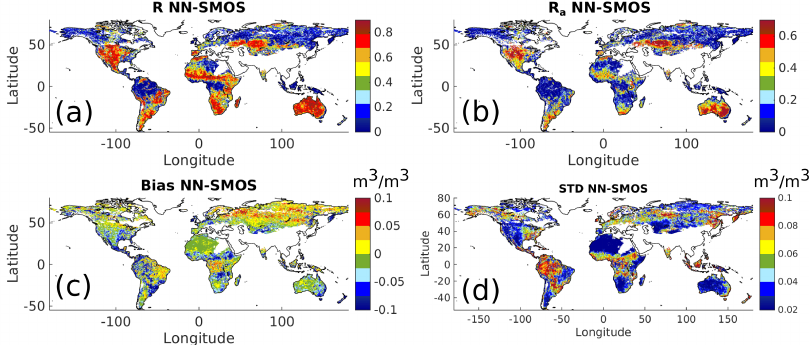
Figure 6. Comparison of AMSR-E NN SM and SMOS L3 SM from June 2010–October 2011. ( a ) Local Pearson correlation of the two SM datasets; ( b ) local Pearson correlation of the anomalies of the two SM datasets; ( c ) bias (mean AMSR-E NN SM minus mean SMOS L3 SM); ( d ) standard deviation of the difference of the two SM